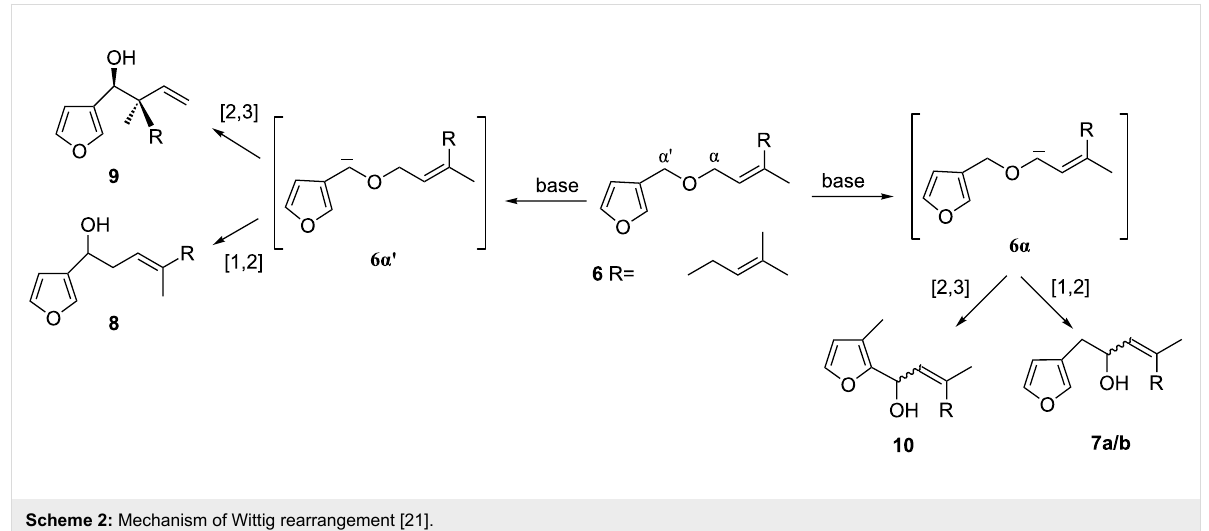
Scheme 2: Mechanism of Wittig rearrangement